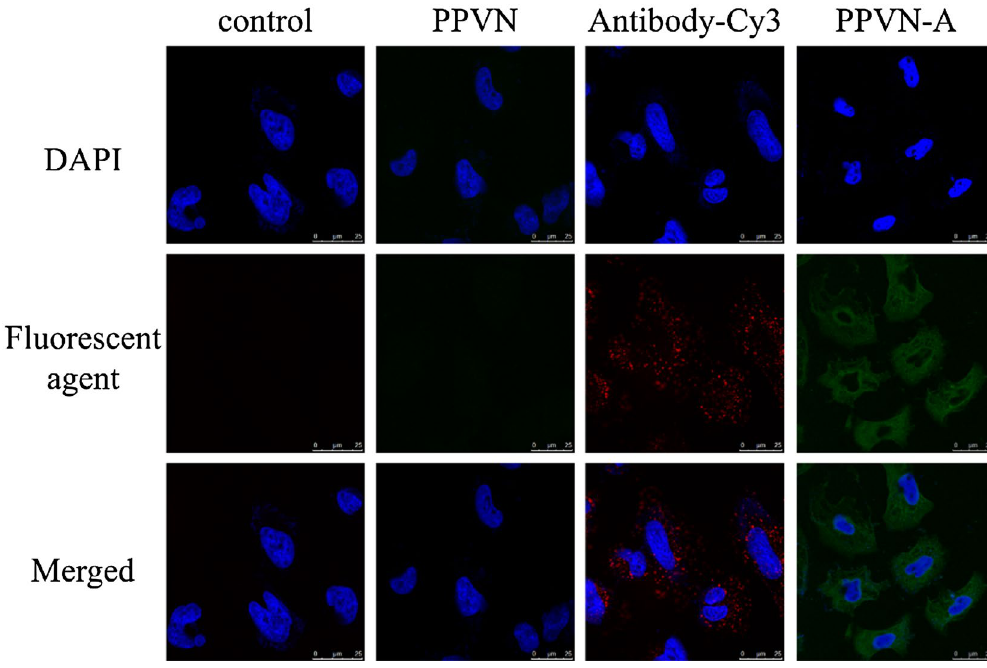
Figure 2. The CLSM images of EGFRvIII overexpressed LN229 cells incubated with unmodified PPVN, antibody-Cy3 (anti-EGFRvIII linked with Cy3) and anti-EGFRvIII modified PPVN-A respectively.